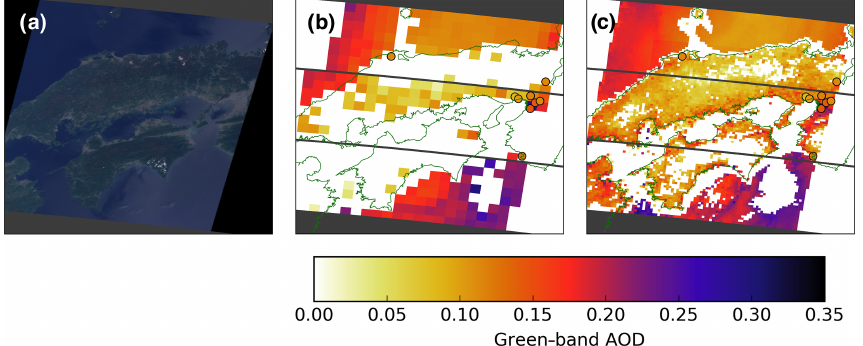
Figure 5. (a) The MISR true-color (RGB) image of the Osaka, Japan, on 27 April 2012 at around 01:55UTC; (b) MISR V22 17.6km aerosol optical depth (AOD); (c) MISR 4.4km AOD retrieved using a prototype algorithm that takes the 1.1km resolution global data as